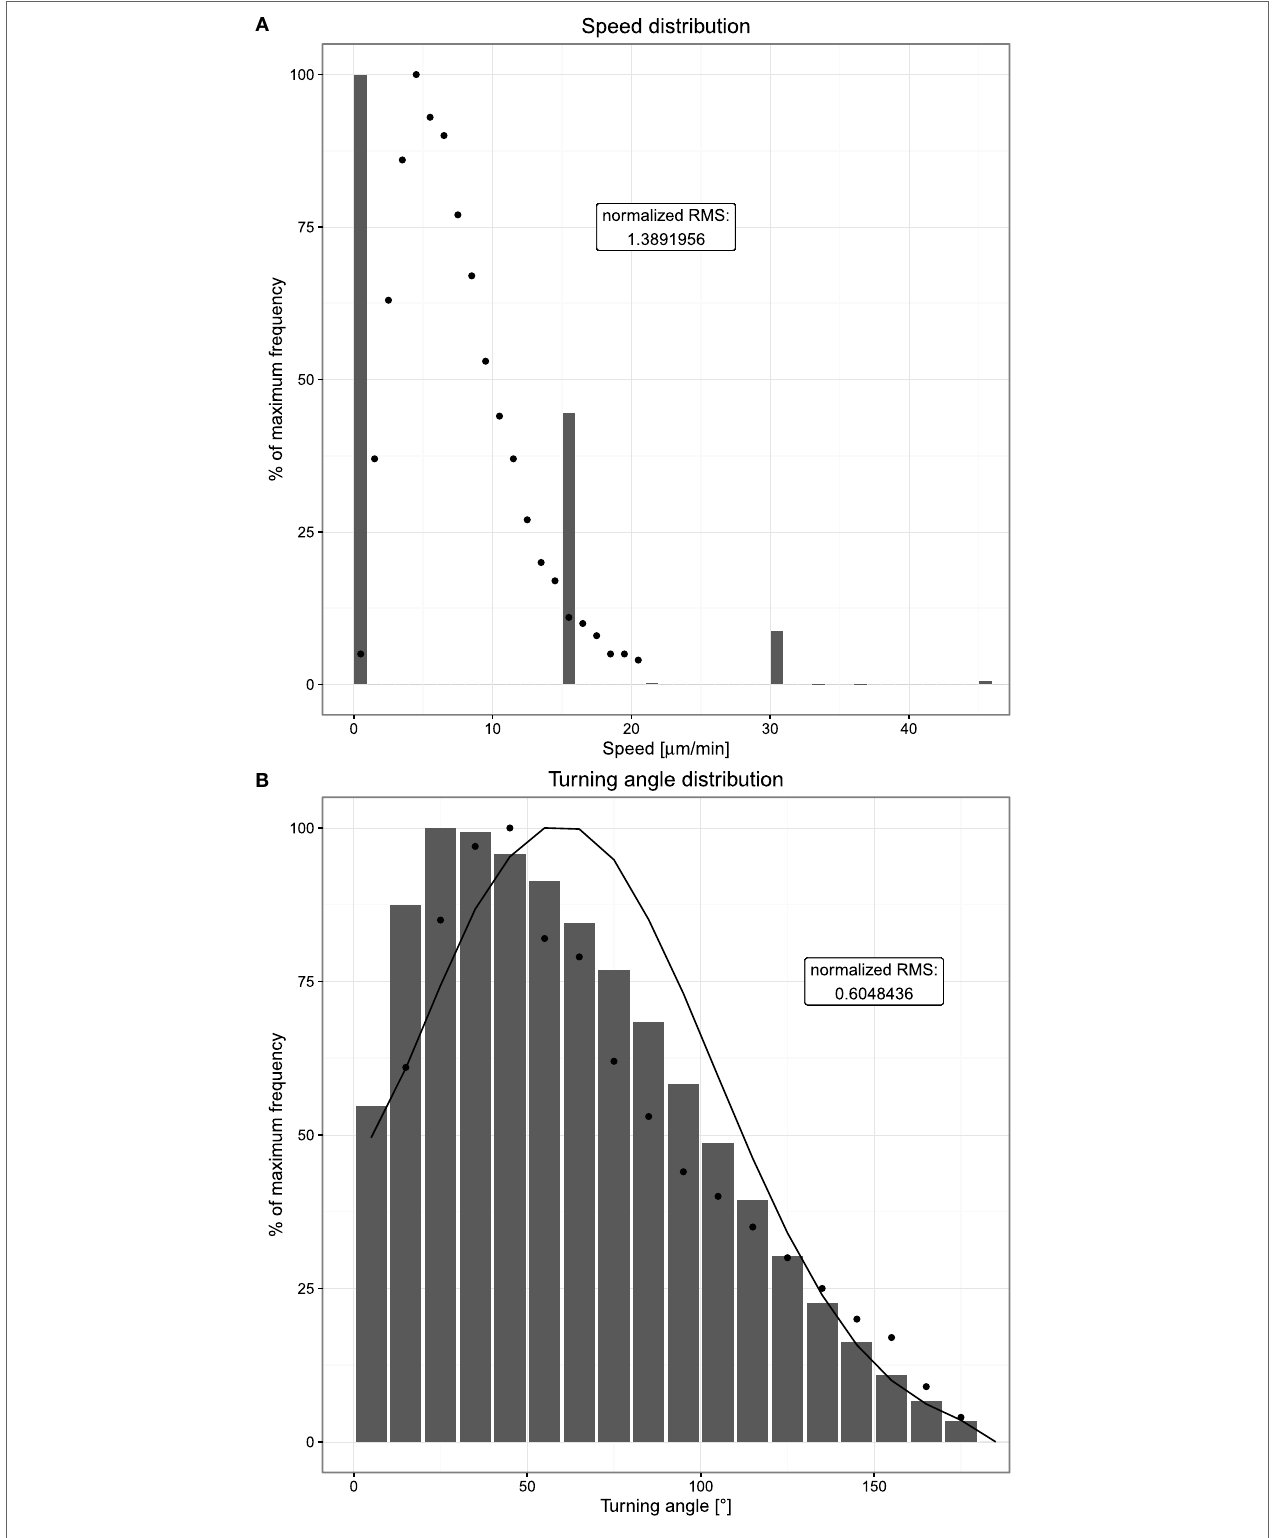
FigUre 3 | speed and turning angle distributions of B cells . Dots indicate experimental measurements, and bars show the mean of 20 simulations. (a) Distribution of observed speeds expressed as percent of maximum frequency. (B) Distribution of observed turning angles expressed as percent of maximum frequency. The distribution indicated by the solid line shows the mean of 20 simulations without chemotaxis. Cells are tracked every 20 s both in silico and in